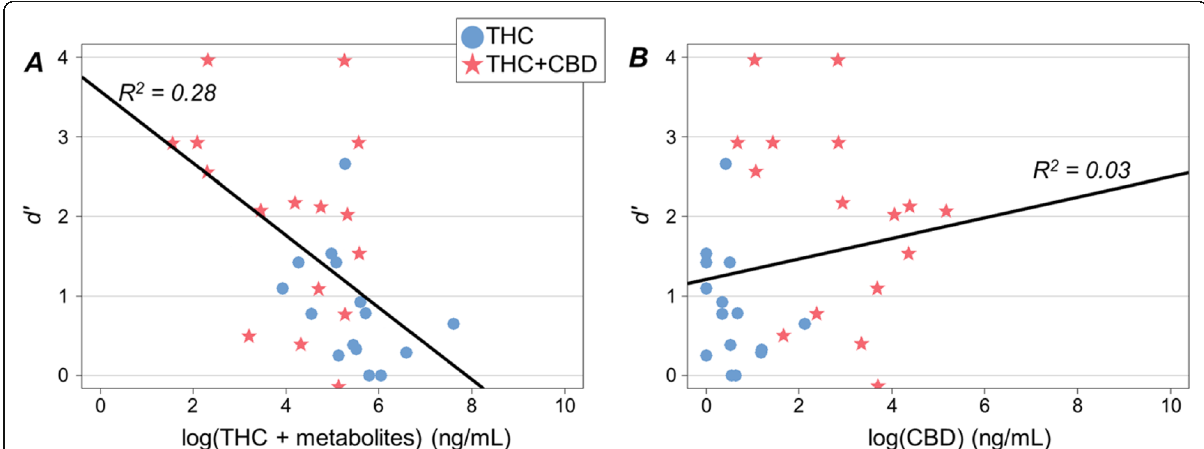
Fig. 2 Accuracy d ’ according to blood biomarkers log (THC + metabolites) ( a ) and log (CBD) ( b ) during posttest, for the two strain groups: THC and THC + CBD. The black lines represent the correlation between accuracy and blood biomakers with R 2